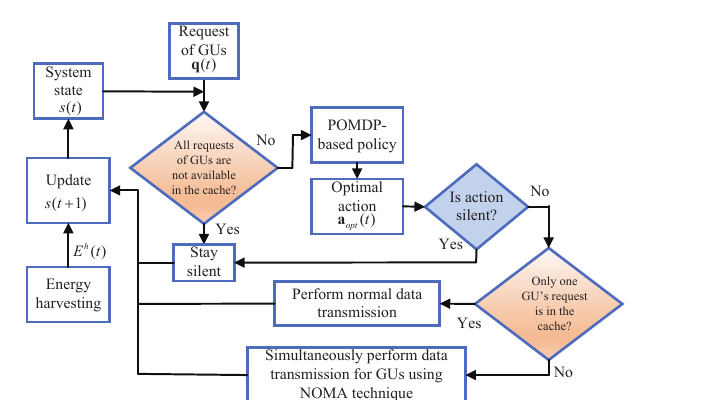
Figure 3. The flowchart of the proposed partially observable Markov decision process (POMDP)-based scheme. TD, temporal